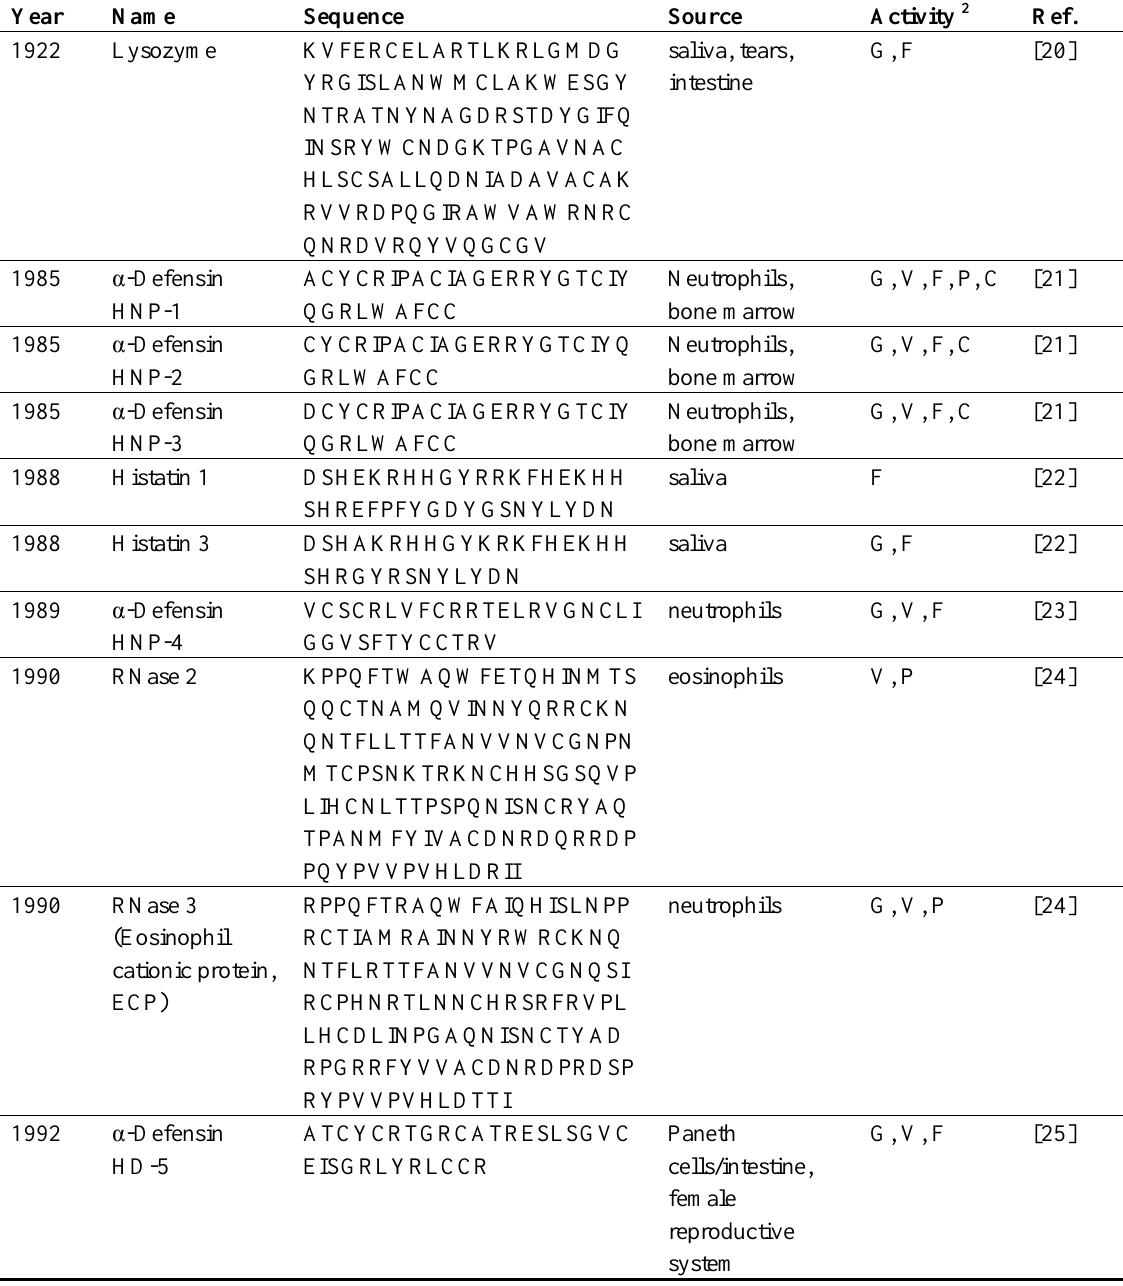
Table 1. Discovery timeline of select human antimicrobial peptides and proteins 1